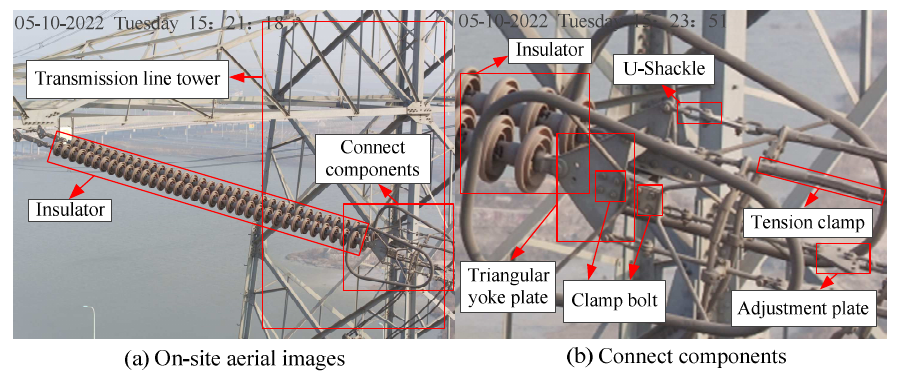
Figure 3. Images captured on site.